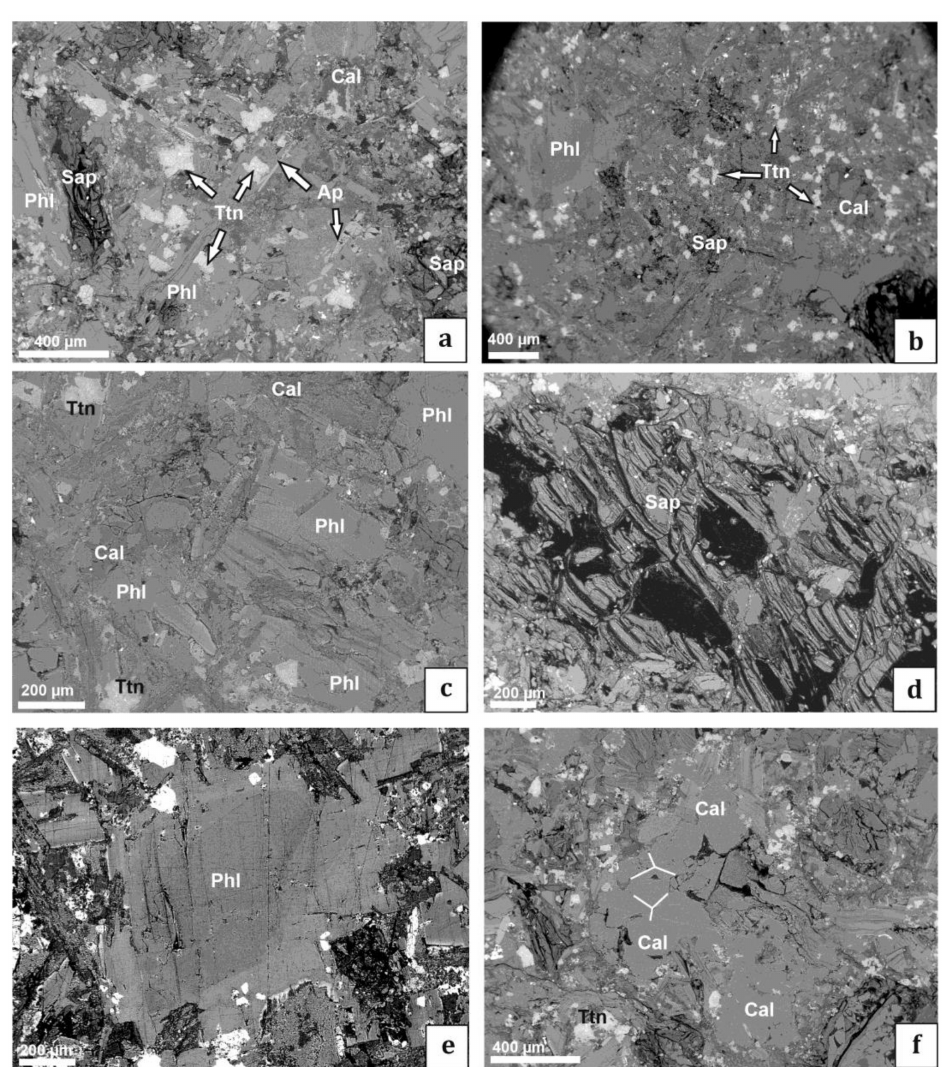
Figure 3. Back-scattered electron (BSE) images showing textural relationships between di ff erent minerals and the morphology of the major minerals: ( a ) Phlogopite and saponite phenocrysts in groundmass of phlogopite, calcite, titanite and apatite; ( b ) phlogopite phenocrysts and calcite vugs in groundmass of phlogopite, calcite and titanite; ( c ) euhedral and subhedral phlogopite, anhedral calcite and subhedral titanite from the groundmass; ( d ) typical oval-shaped aggregate of saponite +/ − talc (possibly after olivine), black spots are the holes; ( e ) zoned groundmass phlogopite with BSE-higher Ba-rich thick rims and BSE-higher Fe-rich thin rims; ( f ) triple junctions in cluster of calcite grains. Mineral abbreviations: Ap = apatite, Cal = calcite, Phl = phlogopite, Sap = saponite, Ttn =